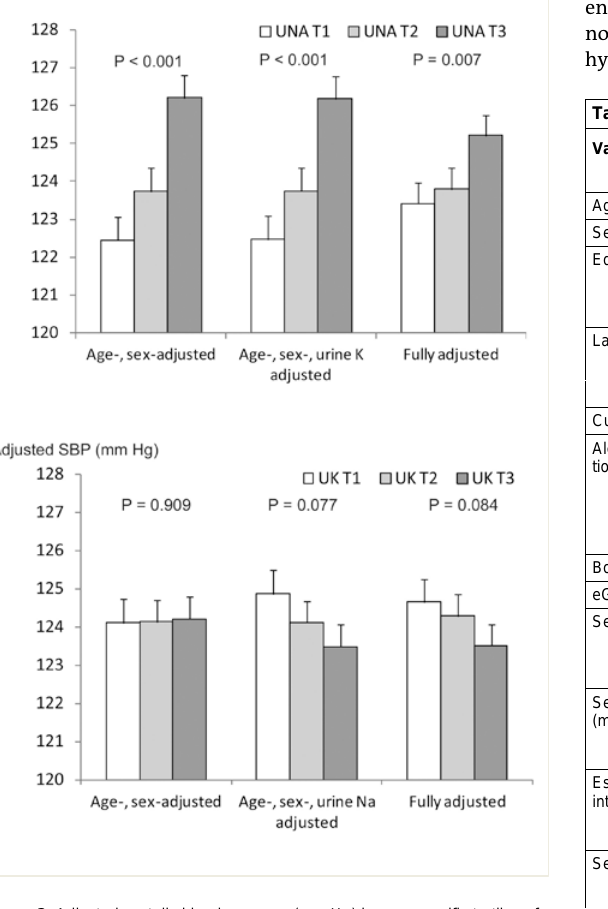
Figure 2: Adjusted systolic blood pressure (mm Hg) by sex-specific tertiles of 24-hour urinary K + (left) or Na + (right) excretion. Fully adjusted models include age, sex, linguistic region, smoking, antihypertensive treatment, body mass index, alcohol consumption, education, sex-specific serum uric acid, urea, Na + , K + and Ca ++ tertiles, sex-specific 24-hour urinary urea, Ca ++ , Na + and K + excretion tertiles, 24-hour urine volume and urinary creatinine excretion per kg body weight. The p-values are from a test for linearity across tertiles in the corresponding model, coding tertiles using 1, 2 and 3. For 24-hour urinary Na + , tertiles 1 (n = 437), 2 (n = 449) and 3 (n = 450) correspond to 93, 148 and 228 mmol, respectively. For 24-hour urinary K + , tertiles 1 (n = 435), 2 (n = 459) and 3 (n =4 42) correspond to 43, 65 and 92 mmol, respectively.